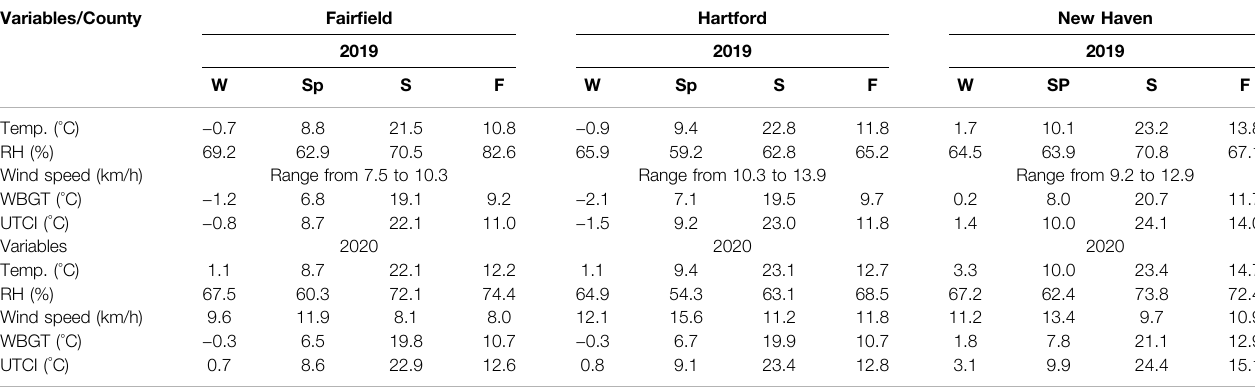
TABLE 6 | Summary of the seasonal averages of the environmental variables in the study locations. Variables/County Fair fi eld Hartford New Haven 2019 2019 2019